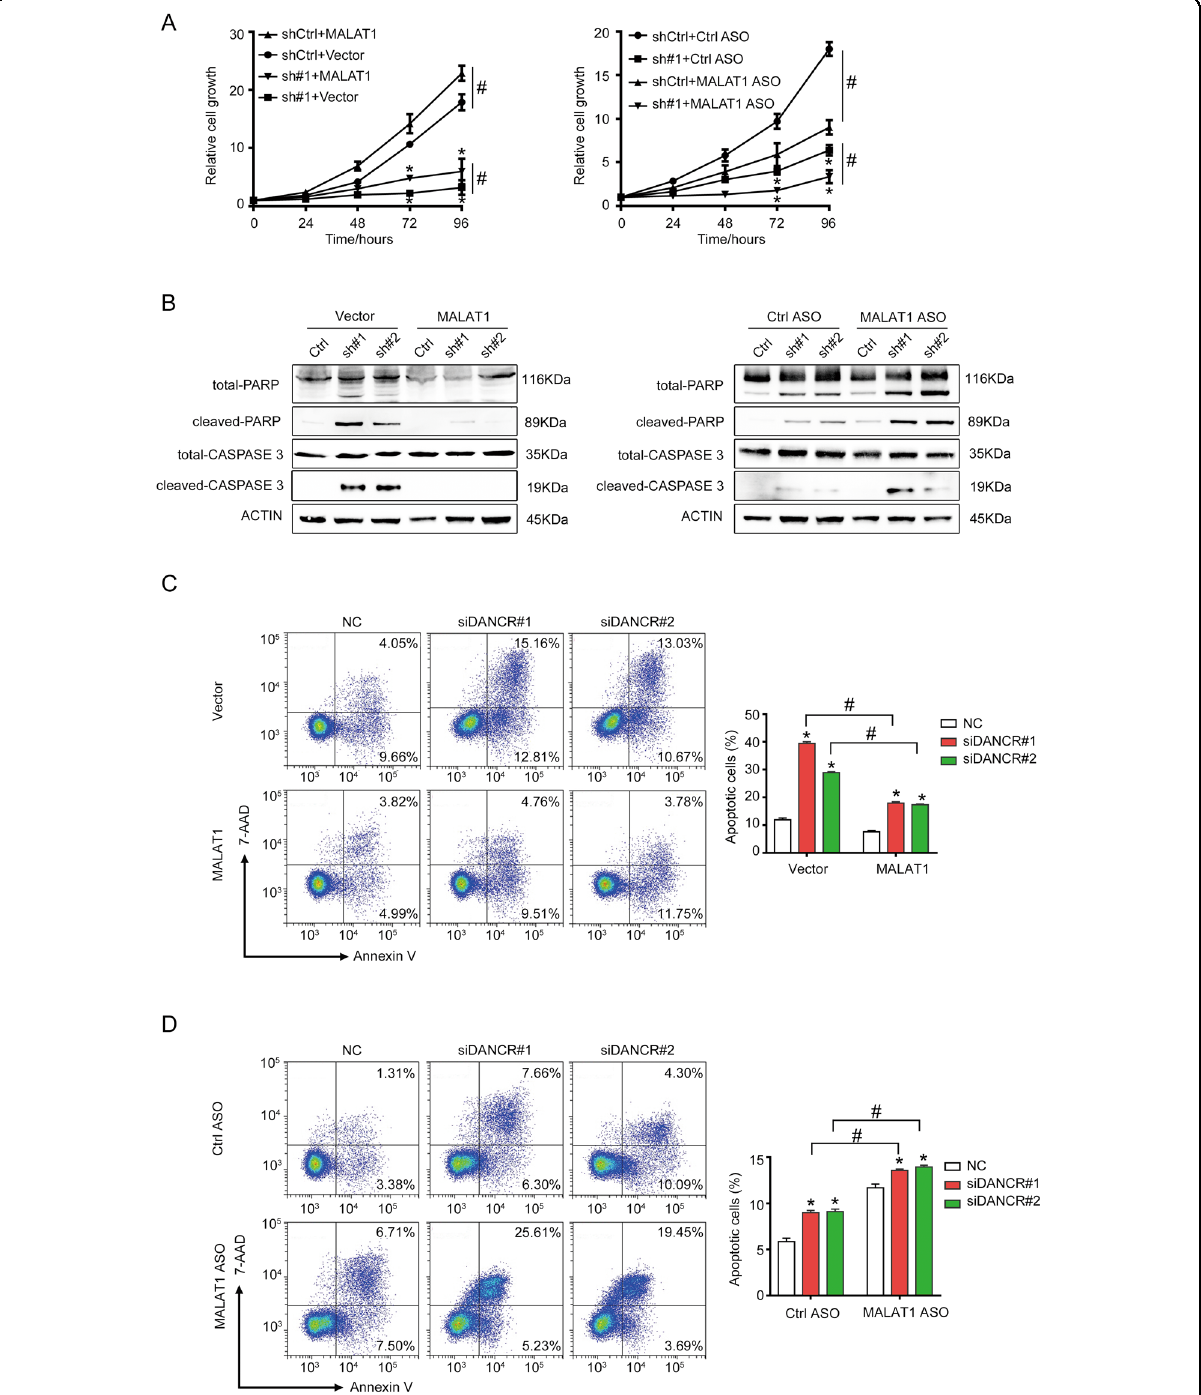
Fig. 5 MALAT1 mediated the anti-apoptotic function of DANCR. A MALAT1 overexpression could partially rescue the growth inhibition caused by DANCR silencing (left), and simultaneously silencing MALAT1 in shDANCR HCT116 cells further inhibited cellular proliferation (right). sh#1, DANCR shRNA#1. ASO antisense oligonucleotides. * and #, p < 0.05. B Western blotting detected MALAT1 overexpression decreased (left), while MALAT1 depletion further increased (right), the expression of cleaved PARP and cleaved CASPASE 3 induced by DANCR silencing. C MALAT1 overexpression decreased DANCR knockdown-induced apoptosis detected with Annexin V fl ow cytometry assay. Representative images and statistical analysis were shown. * and # p < 0.05. D MALAT1 depletion further increased DANCR knockdown-induced apoptosis detected with Annexin V fl ow cytometry assay. Representative images and statistical analysis were shown. * and #, p <